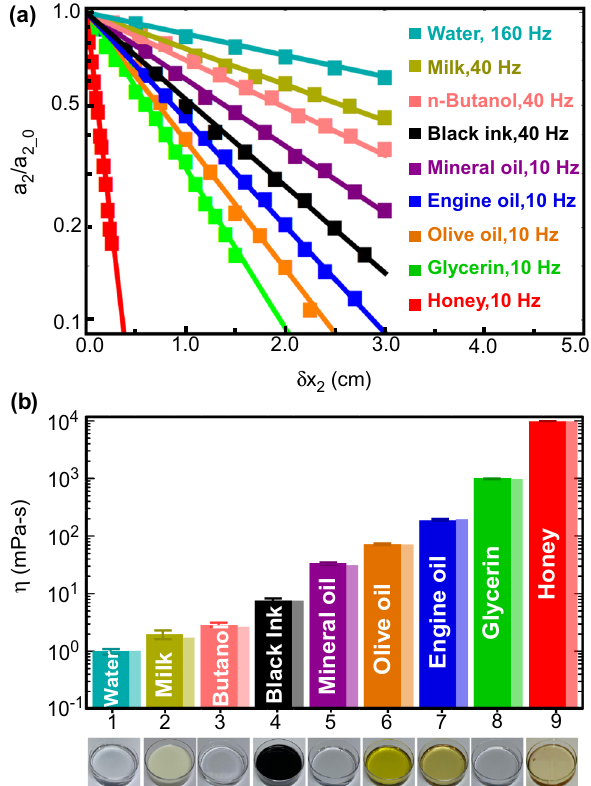
Figure 3. Damping of capillary waves and viscosity measurements. ( a ) Exponential decaying normalized amplitude of surface waves (on logarithm scale) with propagation distance δ x 2 = x 2 − x 2_0 for various tested liquid samples. x 2_0 is the initial position of probe II. Less viscous fluids were excited at higher frequencies as the attenuation is much small at lower frequencies. ( b ) Measured (darker color bars) and expected (lighter color bars) viscosity values for all tested samples. Images of tested liquids of different opacity are also